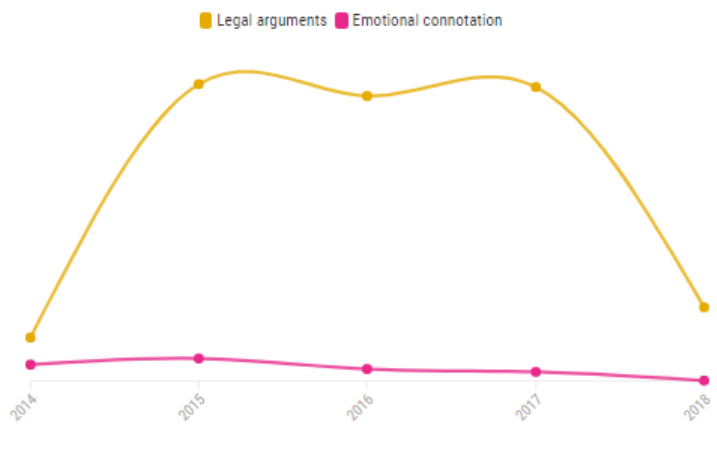
Figure 6: Level of Compatibility of the International Image with Cultural Identity (Source: Authors‟ depiction based on the registry of publications on the websites of both